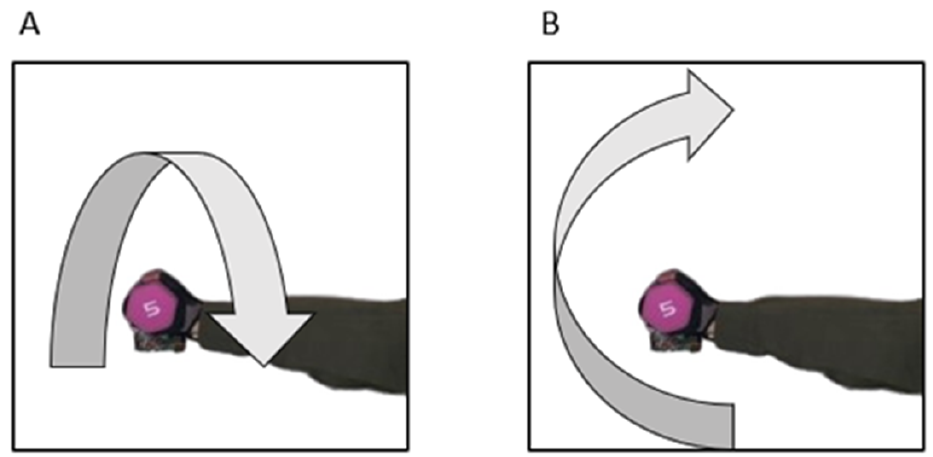
Figure 6. ( A ) Rotating hand when roll angle changes from 0 to 180, ( B ) rotating hand when pitch angle changes from 0 to